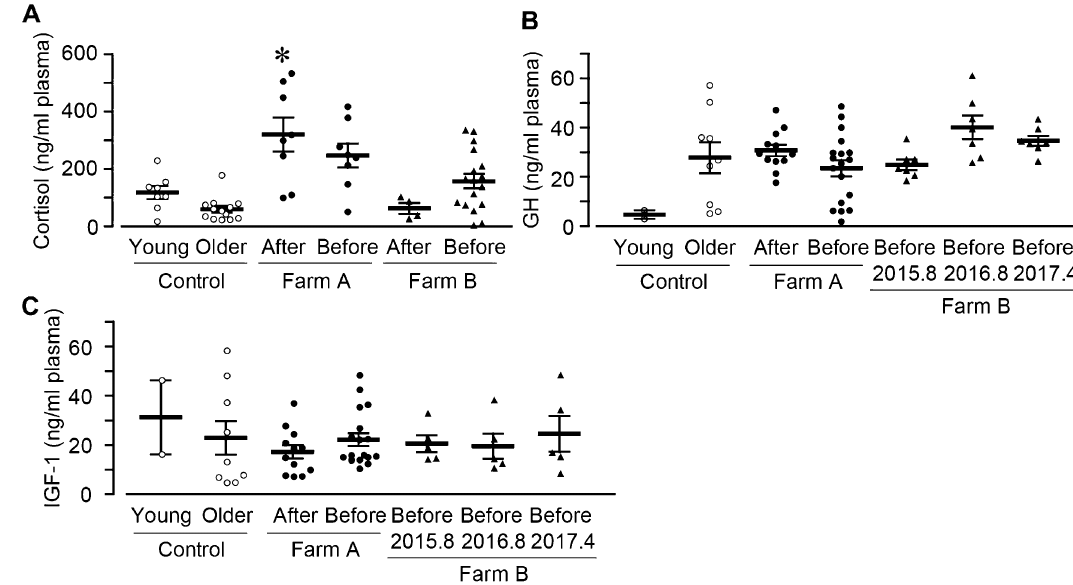
Figure 7. The concentration of anterior pituitary-derived hormones in plasma. Plasma was collected and the levels of anterior pituitary-derived hormones were measured. The summary of ( A ) cortisol (Control, open circle, n = 8 and 13; Farm A, black circle, n = 8 and 9; Farm B, black triangle, n = 4 and 17), ( B ) GH (Control, open circle, n = 2 and 9; Farm A, black circle, n = 14 and 18; Farm B, black triangle, n = 7 each), and ( C ) IGF-1 (Control, open circle, n = 2 and 9; Farm A, black circle, n = 14 and 18; Farm B, black triangle, n = 5 each). Data are presented as mean ± SEM. *P < 0.05 compared with the control